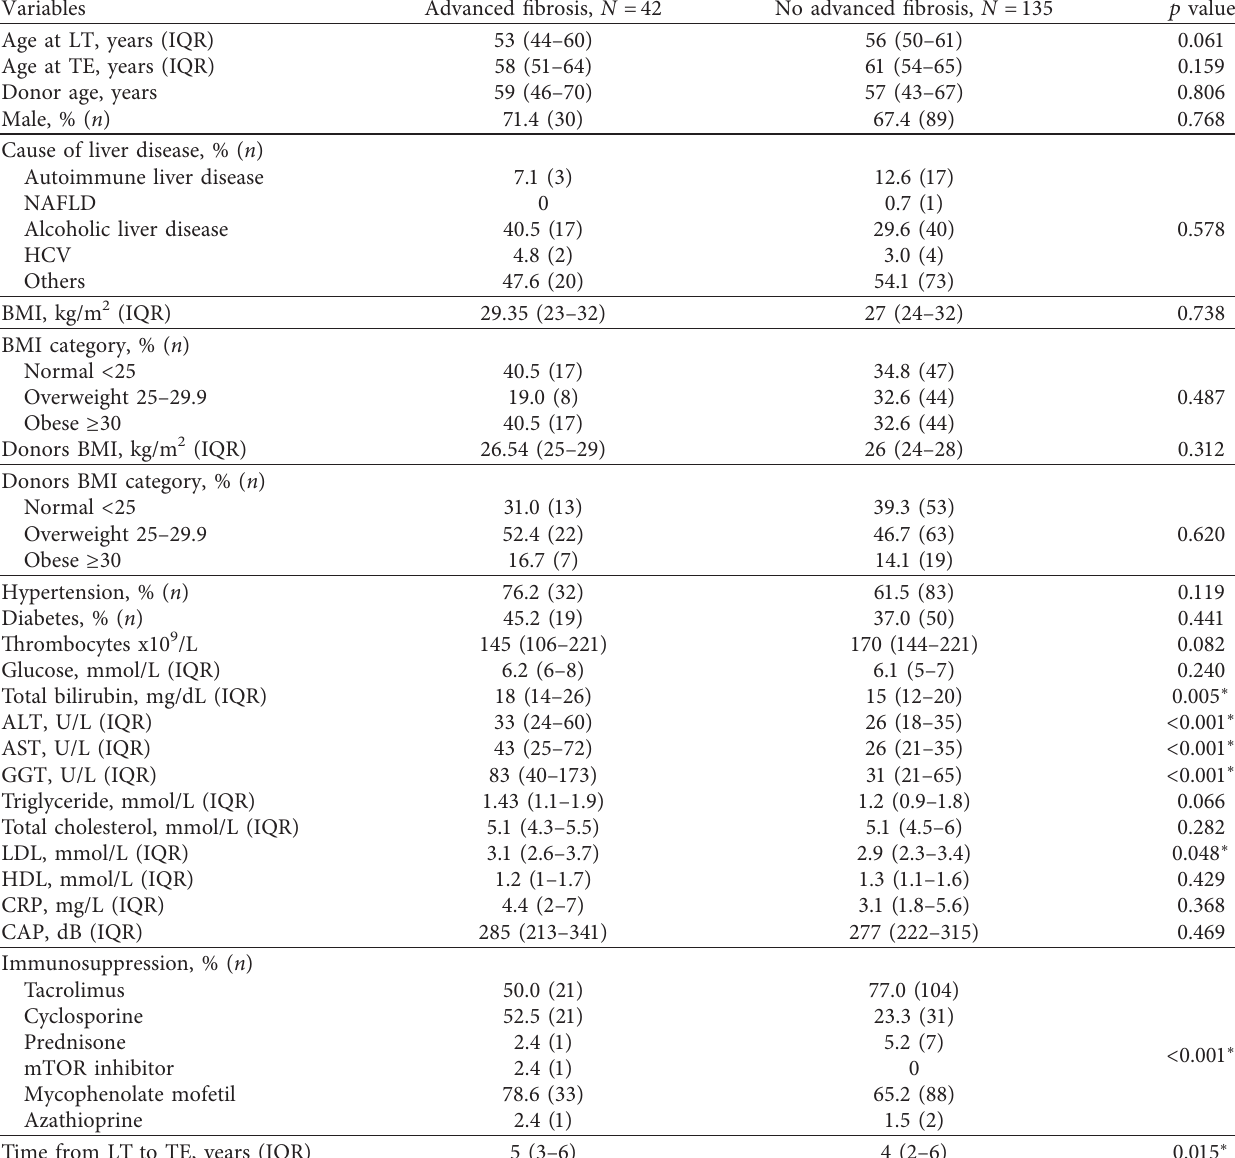
Table 6: Comparison of groups with and without advanced